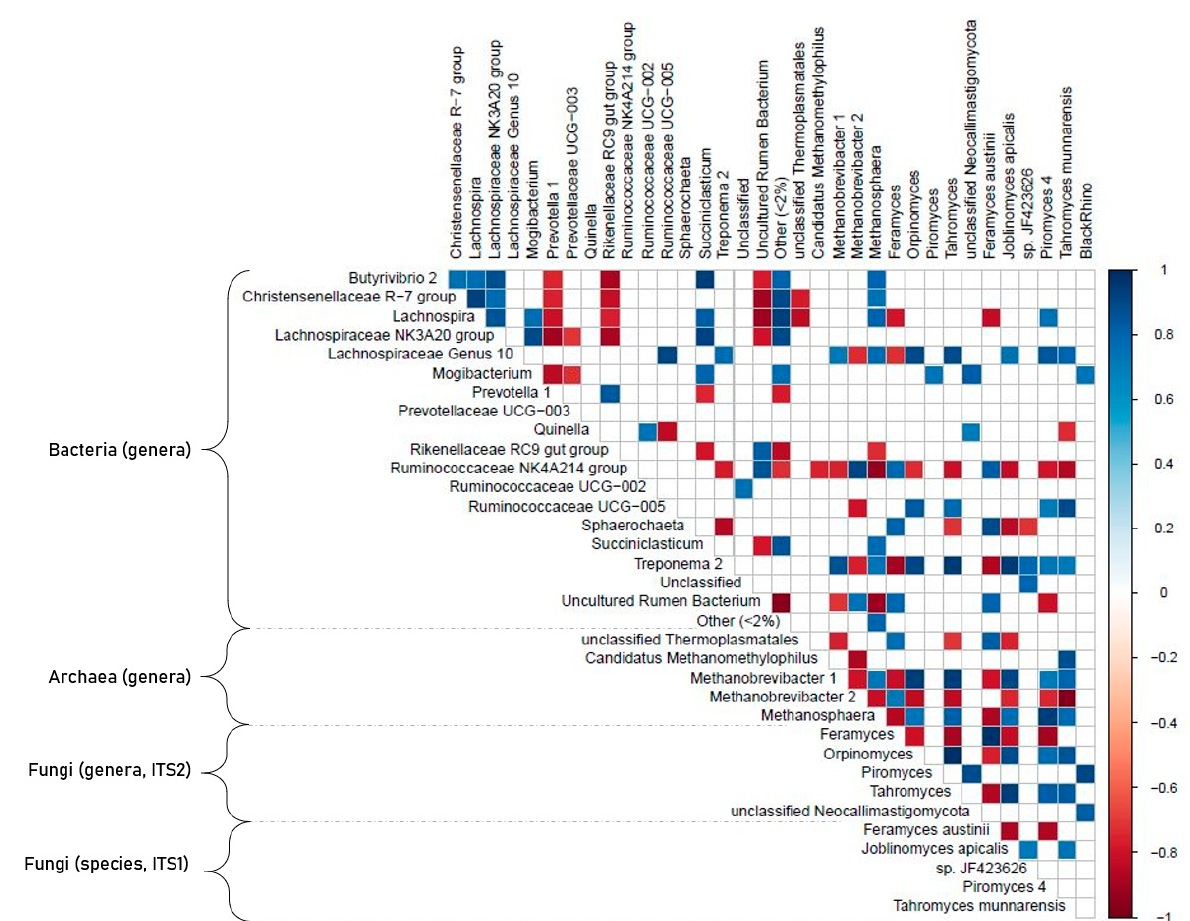
Figure 6. Correlogram of Pearson’s correlation pairs. Based on relative abundance data from the V4 HTS (OTU based), ITS2 HTS (ASV-based), and ITS1 clone library approaches. Only pairs with p < 0.05 and − 0.7 < r < 0.7 are shown.